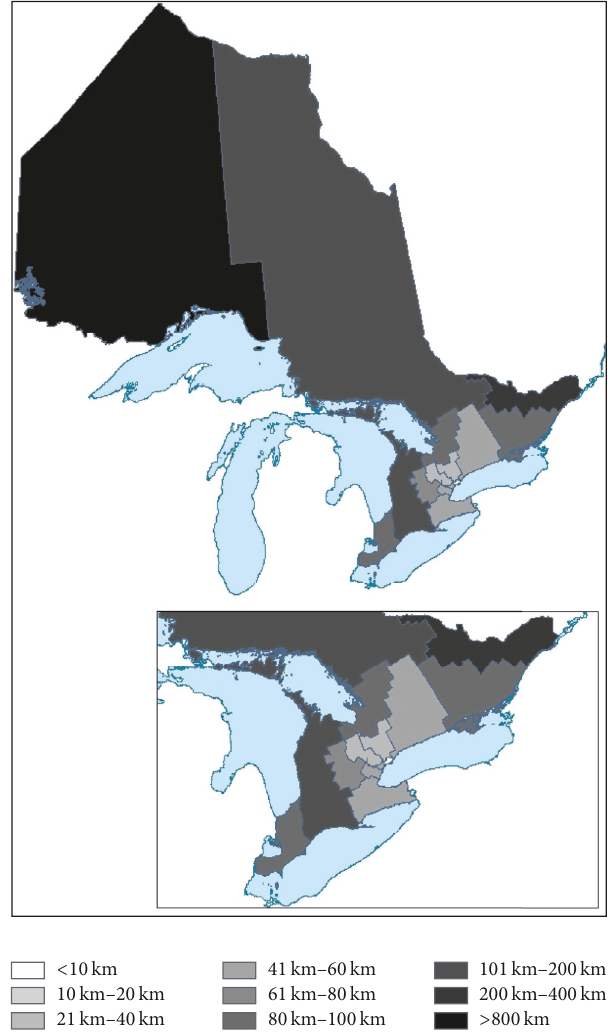
Figure 2: Median distances (km) between the residence of patients receiving psychiatry via telemedicine and their